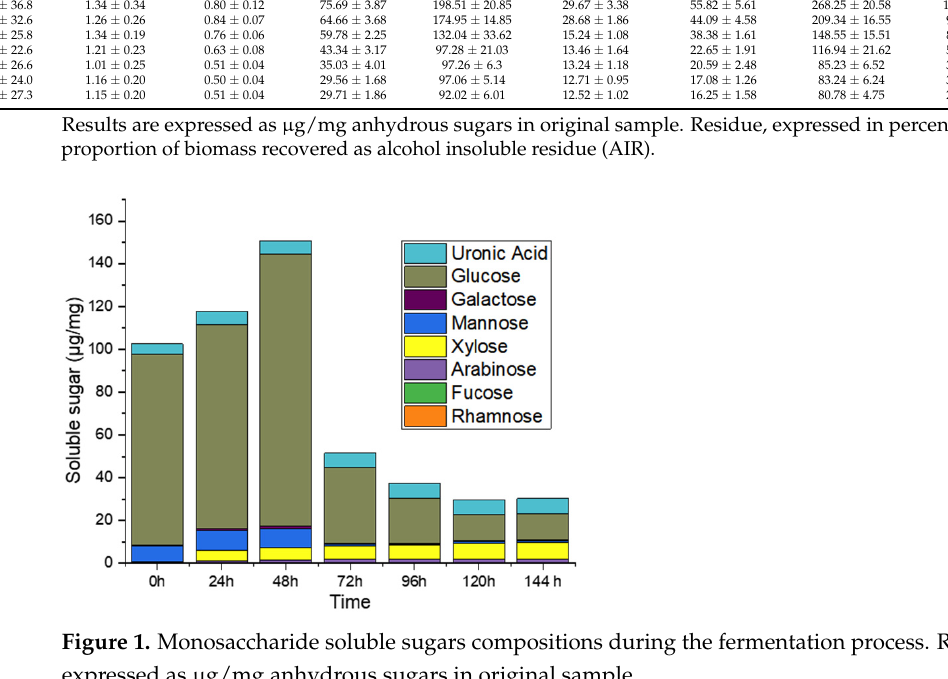
Figure 2. Percentage of protein, soluble and insoluble sugars detected during the fermentation pro- cess. Red square: crude protein; blue triangle: insoluble sugar; grey circle: soluble sugar. Results are expressed as percentage calculated on dry matter.